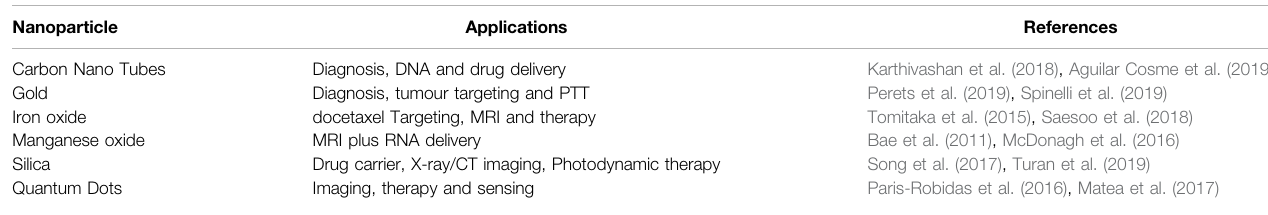
TABLE 1 | An overview of nanoparticles and their applications in nervous